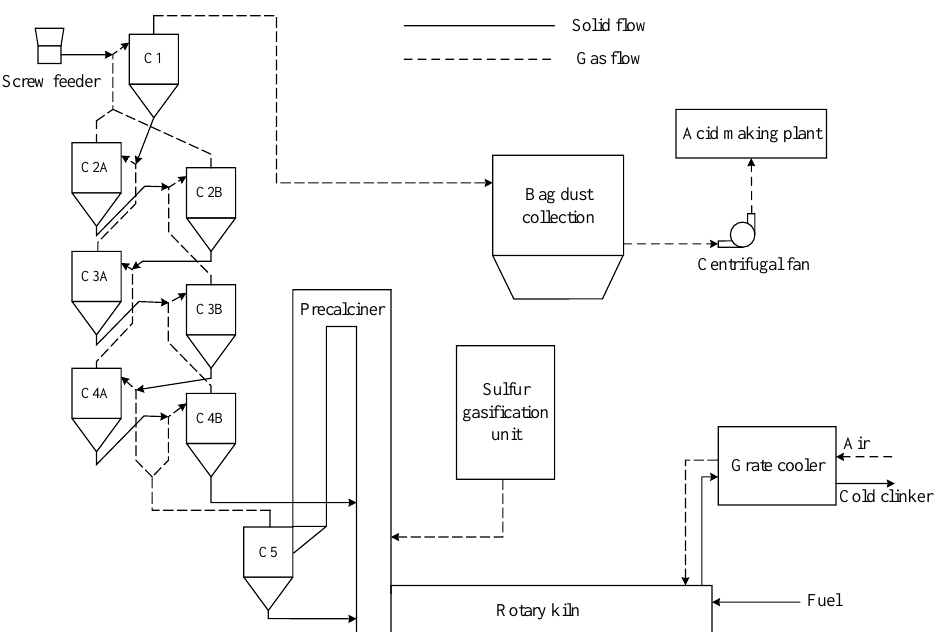
Figure 8. Process flow diagram of sulfur gas reduction phosphogypsum system.